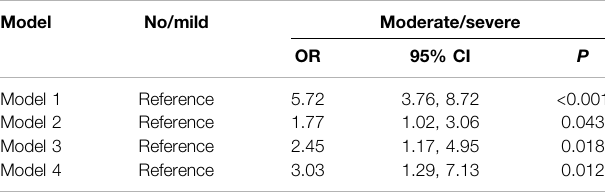
Model 3: further adjusted for education, marital status, smoking status, and drinking status based on Model 2. Model 4: further adjusted for hypertension, diabetes, stroke, and asthma based on Model